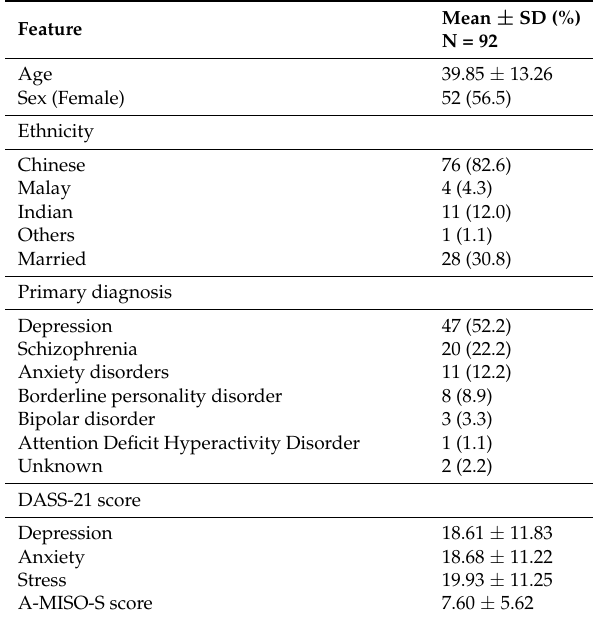
Table 1. Demographic features of